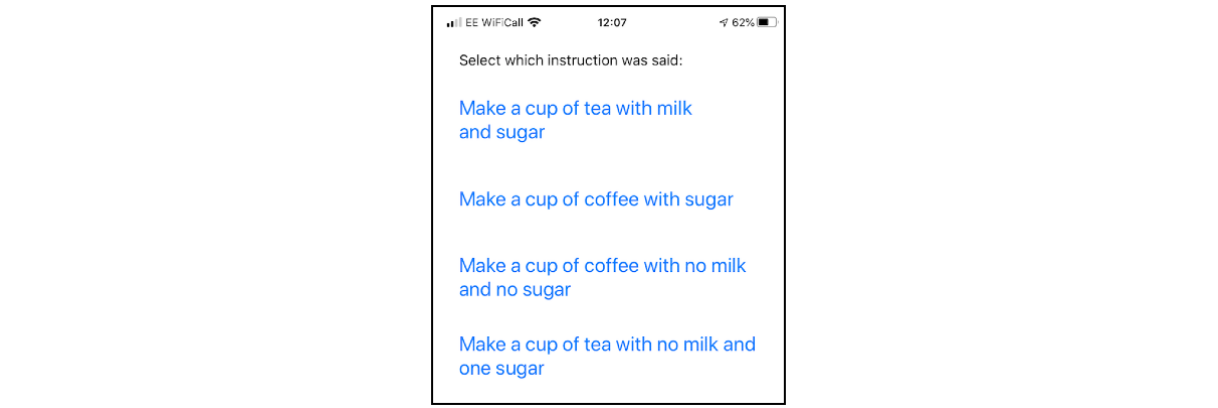
Figure 1. Screen where the user chooses the instruction that was heard.